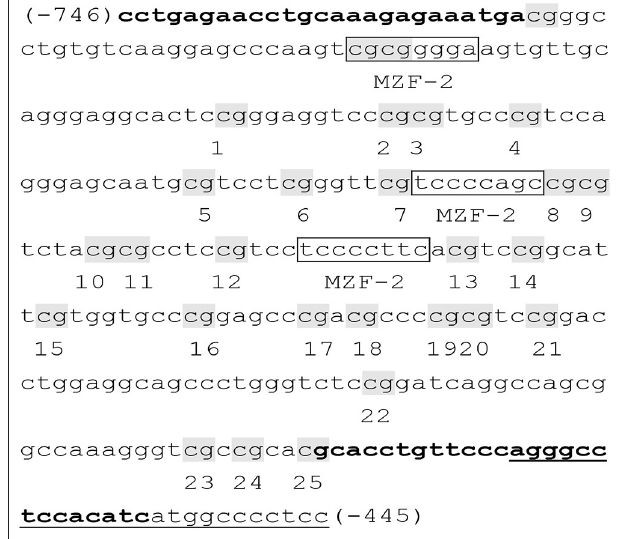
FIGURE 1 | Primer sequences of the TERT promoter (38). The examined TERT promoter region includes nucleotides (nts) 1254,147–1253,148 and spans 25 CpGs within nts − 746 to − 445 (positions are given relative to the transcription start site), containing 3 binding sites (boxed) for myeloid-specific zinc finger protein 2 (MZF2). CpG sites are labeled with shadow and numbered from 1 to 25. Primers were shown in bold, and the primer outer R was